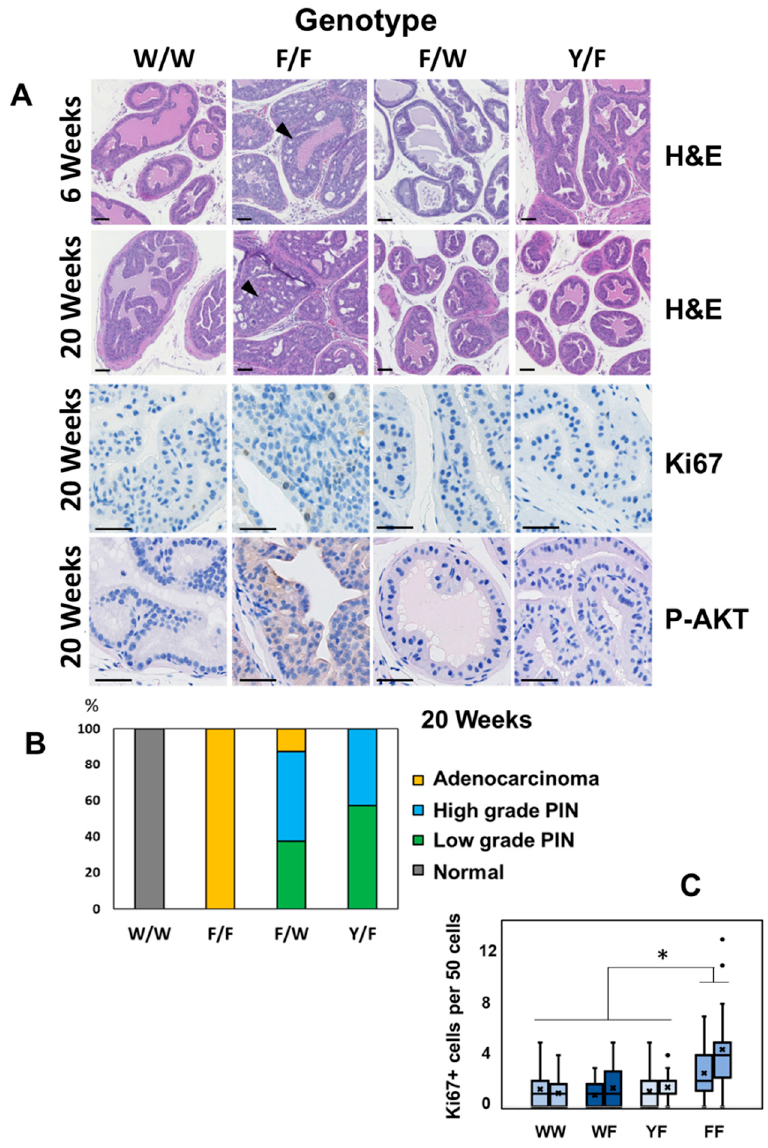
Figure 2. ( A ) Representative sections of H&E (hematoxylin and eosin) stained prostate tissues from the indicated ages and genotypes of mice. Arrowheads show Prostate Intraepithelial Neoplasia (PIN) in 6-week-old Pten F/F mice and adenocarcinoma in 20 week F/F mice. Ki67 immunohistochemistry was used to detect proliferating cells in 20-week sections and parallel samples were also probed by IHC for AKT phosphorylation (Ser-473). Scale bars: 100 μ m. ( B ) The most aggressive pathology evident in each prostate at 20 weeks of age is noted for each genotype. N = 6 per genotype. ( C ) The number of Ki67 positive nuclei per 50 cells was counted for 25 regions of the prostate. Data are shown for pairs of mice from the indicated genotypes. Boxes represent quartiles and the cross (x) represents the mean number of proliferative cells per 50 cell group. Each FF sample had significantly more Ki67 positive nuclei than each WW sample ( p < 0.05 Mann–Whitney U Test) denoted by *. W/W = Pten + / + ; W/F = Pten + / flox ; Y/F = Pten Y138L / flox ; F/F = Pten flox / flox .